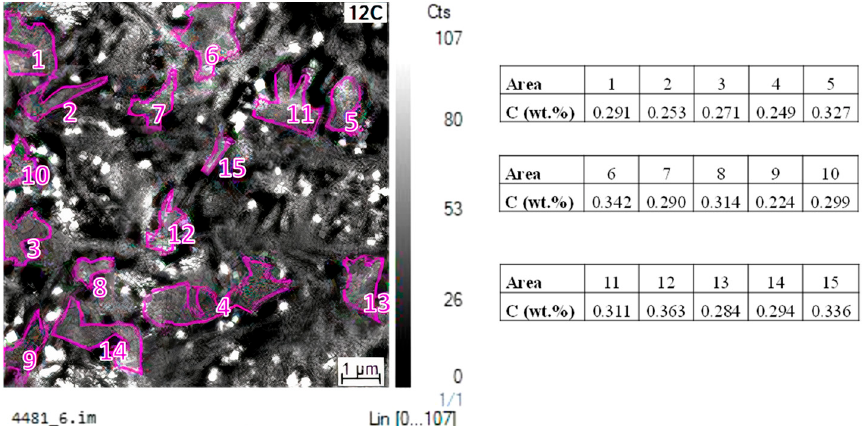
Figure 8. Example of one 12 C ion map (left side) and carbon content estimated in different areas of this zone (right side) in M-MnNi steel sample partition-treated at 650 °C during 300 s and in QT15 condition. The areas selected for carbon content analysis are surrounded in purple in the 12 C ion map.